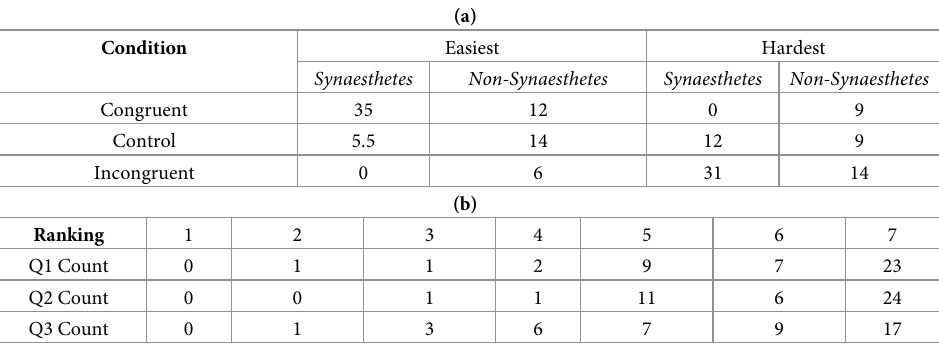
Table 4. Synaesthetes’ (n = 43) and non-synaesthetes (n = 35) questionnaire results as derived from their answers to the questionnaire. (a) Difficulty Rankings. (b) Likert Rankings. (a) Condition